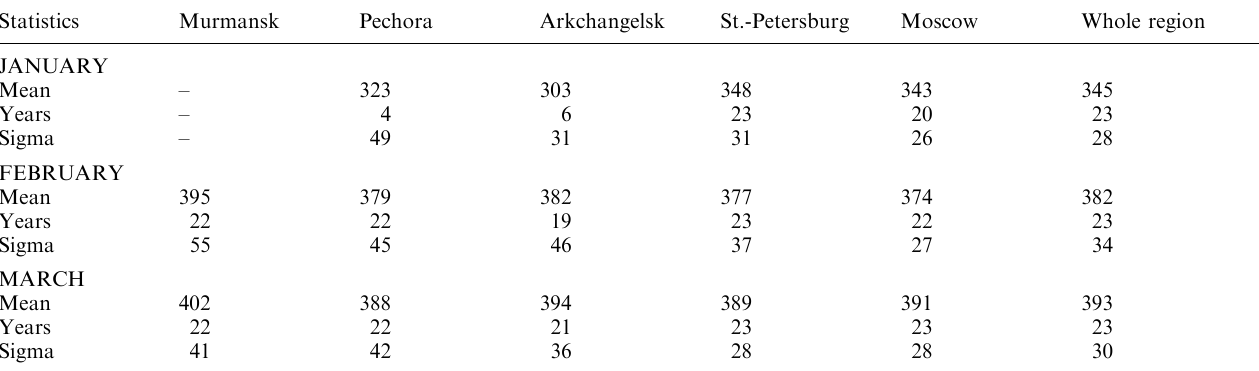
Table 2. Long-term (1973–1995) monthly means of total ozone (in Dobson units) for the five Northeastern Europe stations from January to March. Besides the long-term means, for the each station the following information is added: the number of years of data which are used to calculate the means, and the standard deviation (sigma) of total ozone for the given month and station